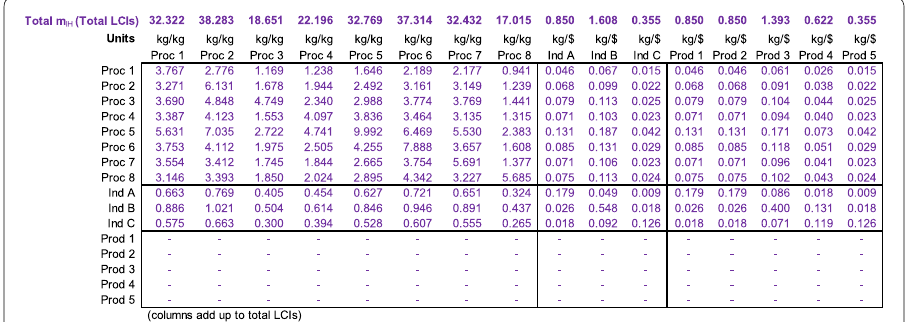
Fig. 5 Example decomposition of life cycle inventories by origin (industry or